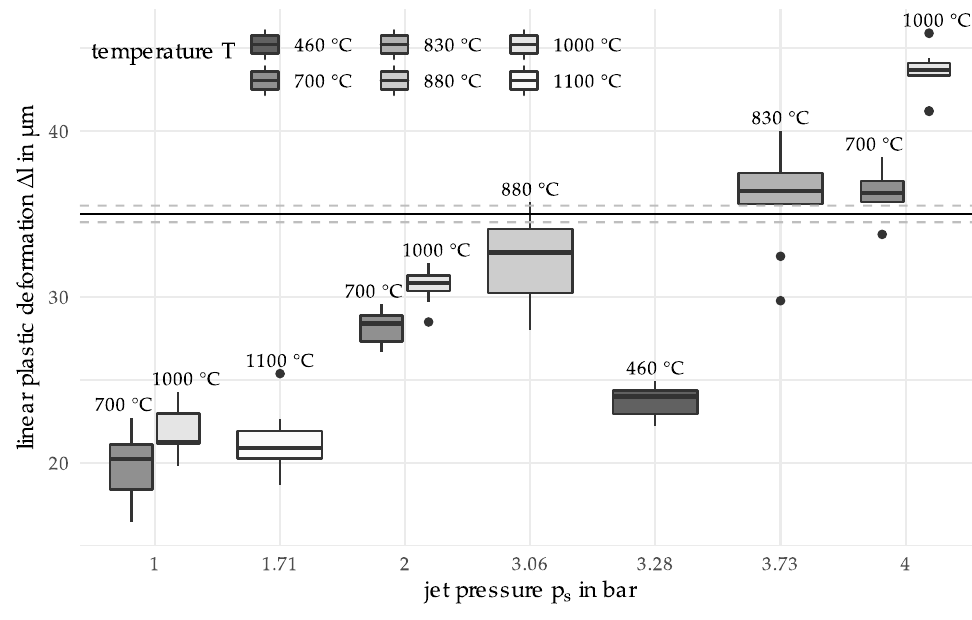
Figure 8. Boxplot comparison of the data of all measurements.